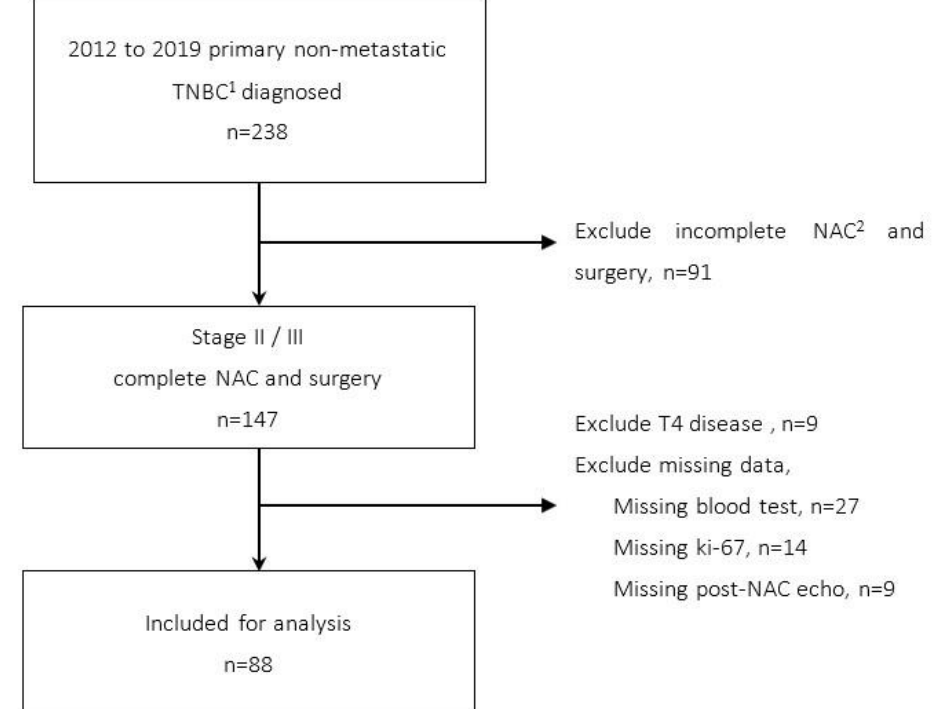
Figure 1. Flowchart of patients recruited in this study. 1 TNBC: triple negative breast cancer. 2 NAC: neoadjuvant chemotherapy .